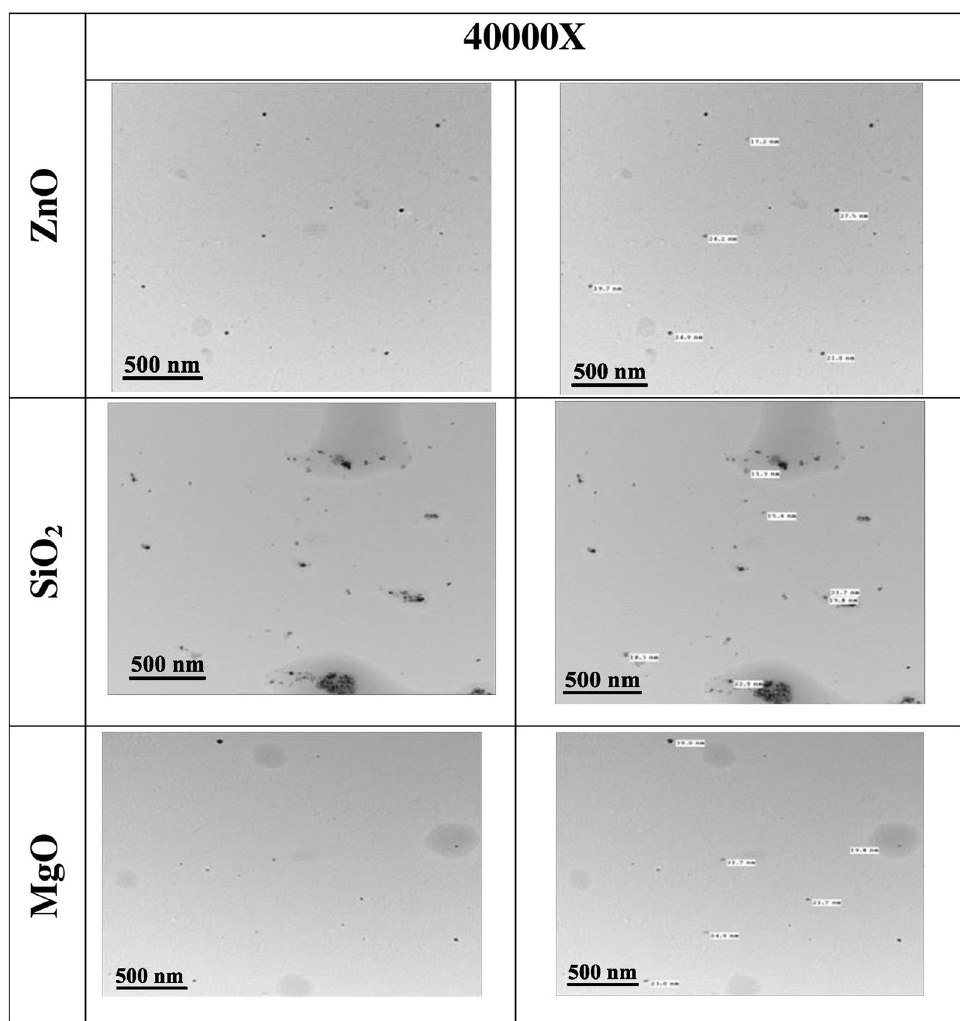
Figure 2. The TEM micrograph of MgO, SiO 2 , and ZnO nanoparticles synthesized by lemon peel